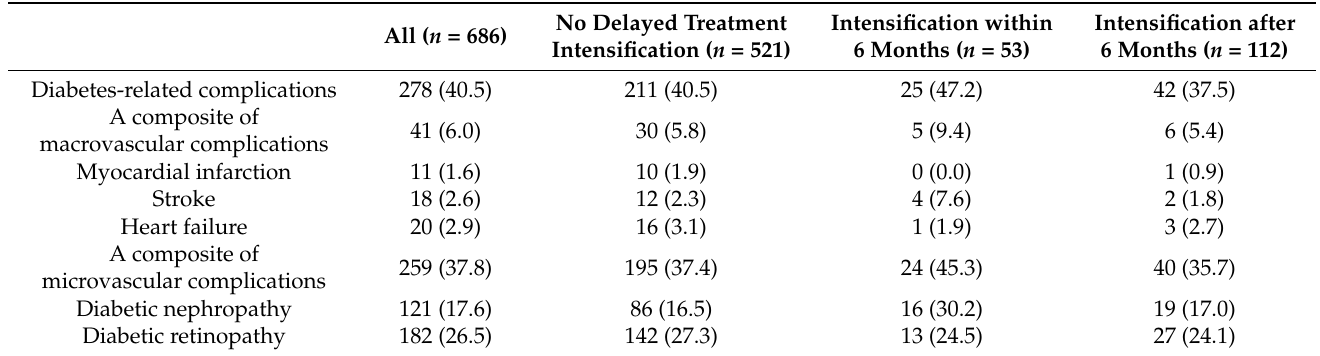
Table 2. Number of patients having diabetes-related complications.